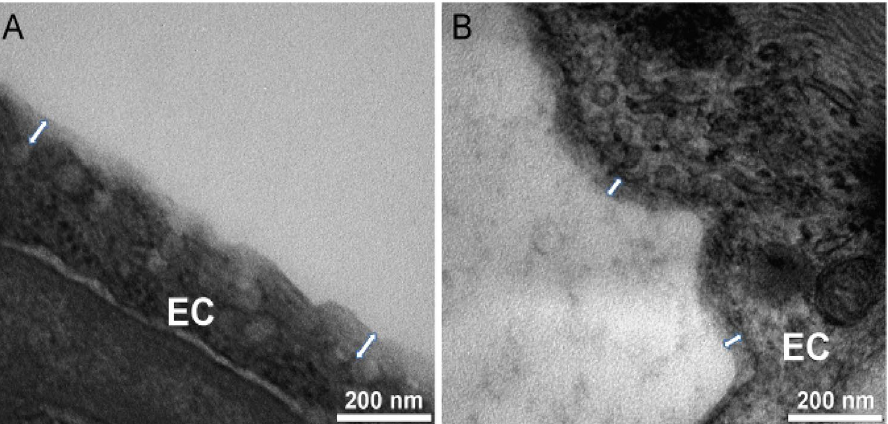
Figure 2. Glycocalyx-like structure assessment of lymphatic vessels. High-magnification transmission electron micrographs (scale bar: 200 nm) showing the endothelial glycocalyx-like structure in a vein ( A ) and in